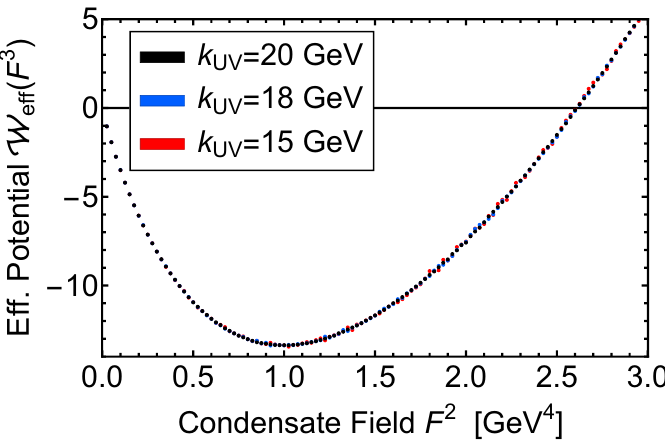
( F a ) : It is shown for in- W eff